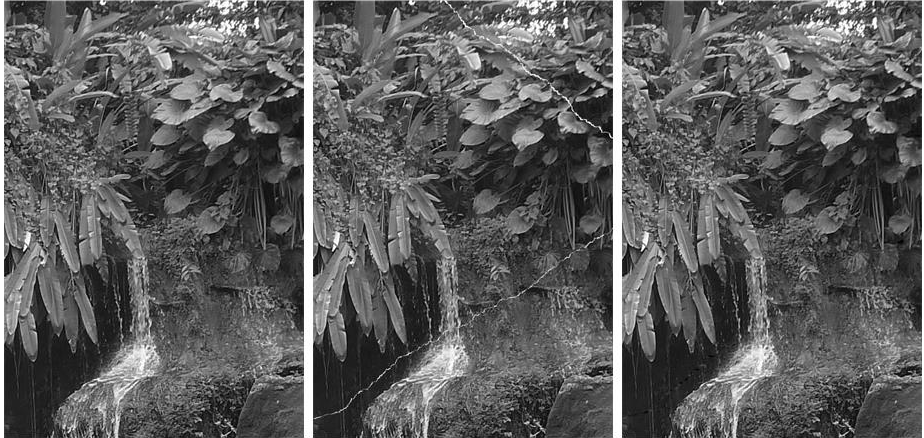
Fig. 2. The second test photo (scenery): the undamaged, the ripped, and the recovered versions were arranged from left to right in